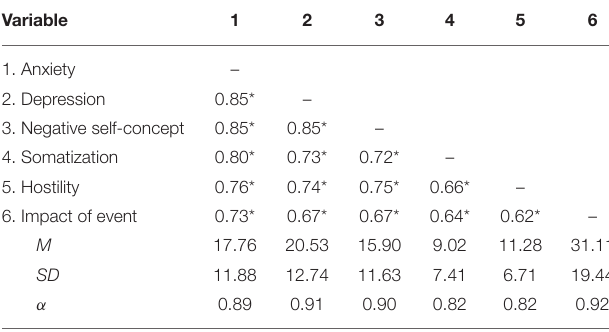
TABLE 1 | Means, standard deviations, reliability coefficients, and bivariate correlations for scores among variables.